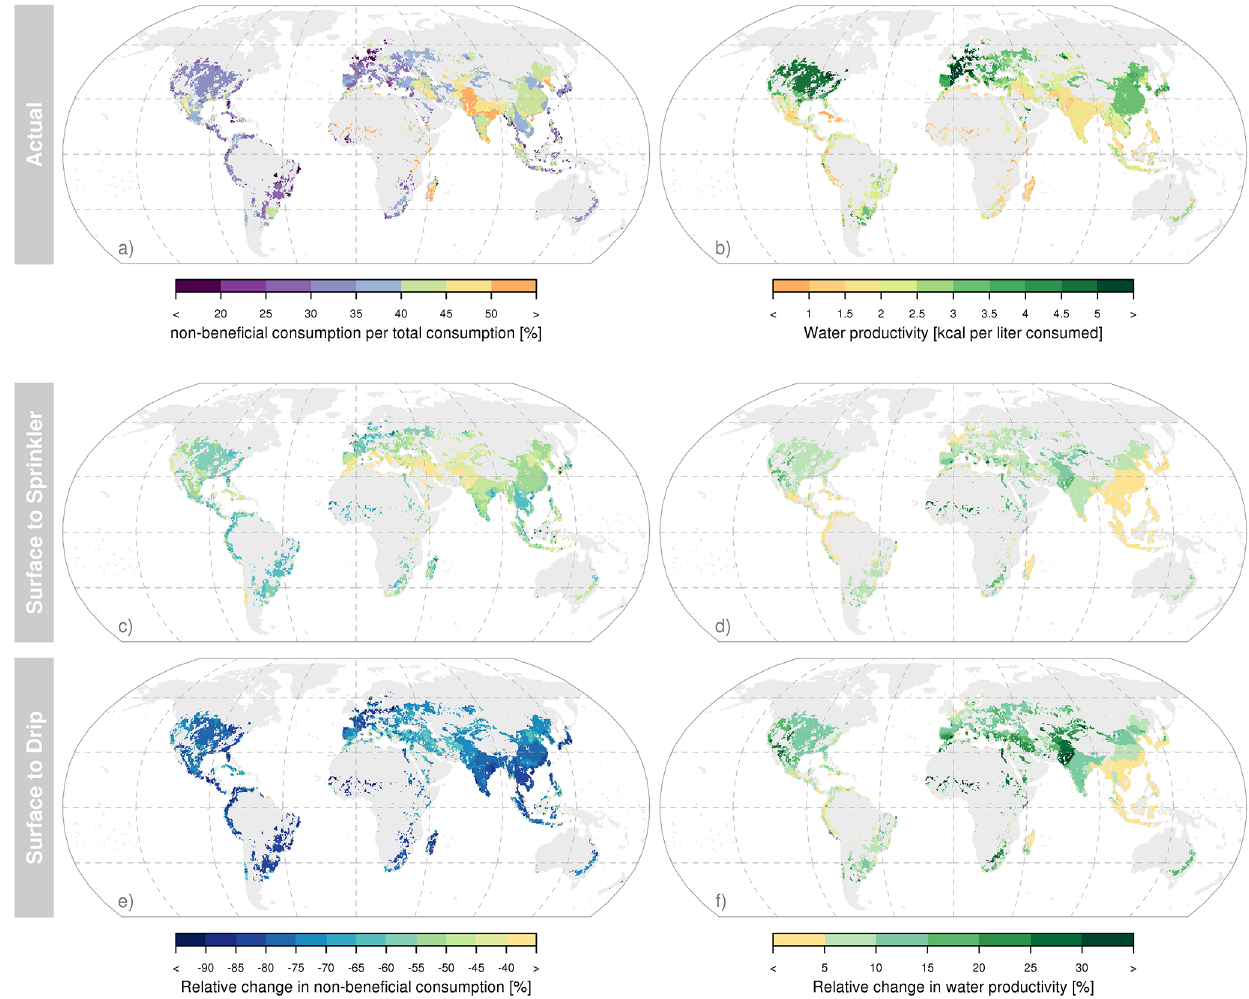
Figure 7. Basin-level aggregation of ratio of non-beneficial consumption and total consumption (RNC; a ), and water productivity (kcal from irrigated crops per consumed liter of blue and green water; b ) given the current distribution of irrigation systems. (c) – (f) show the relative change in E b and water productivity given a transition from surface to sprinkler (c, d) and surface to drip systems (e, f) , respectively (all-surface, all-sprinkler, and all-drip scenarios). Pastures and “others” are